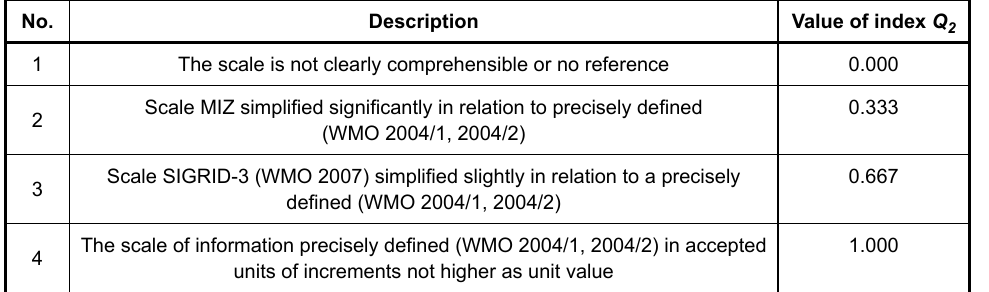
Table 2. Comprehensibility of scale (legend) index Q